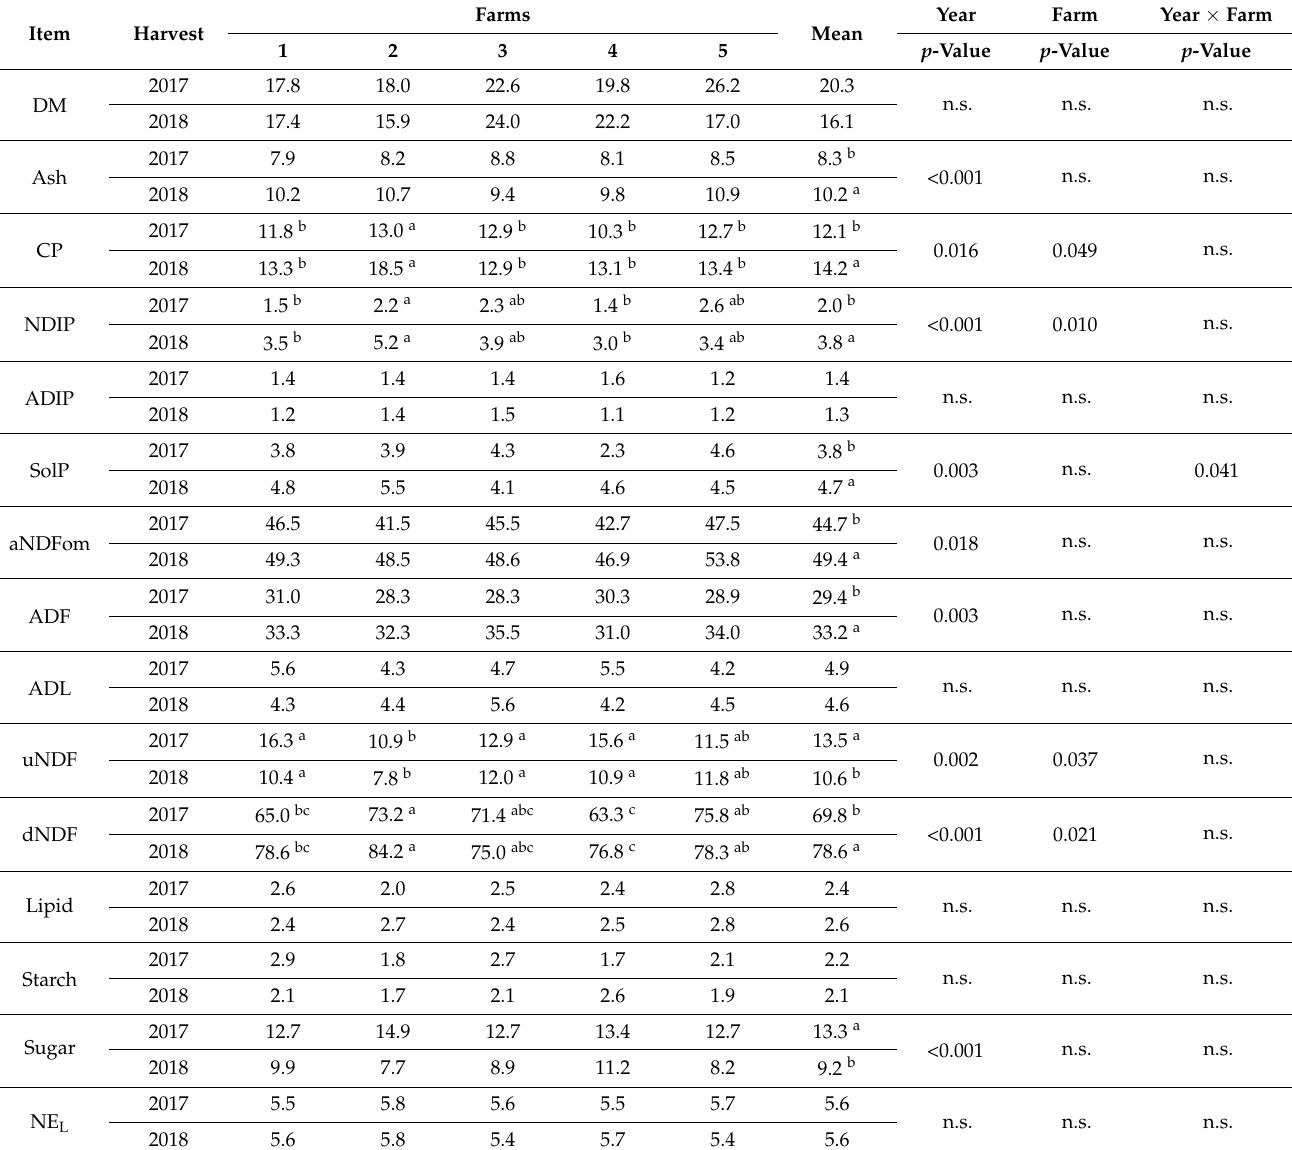
Table 2. Statistical analysis of Near-Infrared Reflectance Spectroscopy